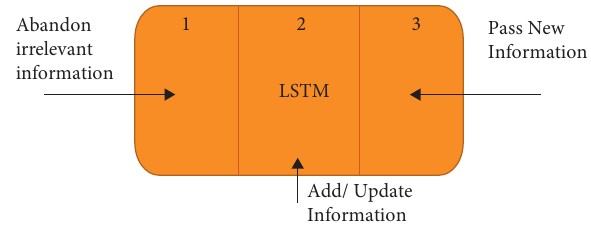
Figure 2: The architecture of the